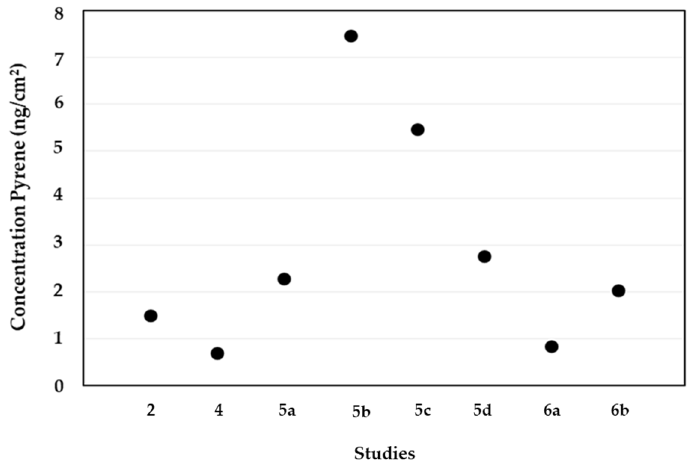
Figure 2. Concentrations of pyrene on the skin of firefighters after firefighting activities (2— Fernando et al. [45] (total of neck, wrist, back, forehead, and fingers); 4—Wingfors et al. [37] (neck); 5—Andersen et al. [43] (a—Campaign 1; b—Campaign 2; c—Campaign 3; d—Campaign 4) (neck); 6—Banks et al. [42] (a—diesel pan fire; b—particleboard fire) (total of neck and wrist)).